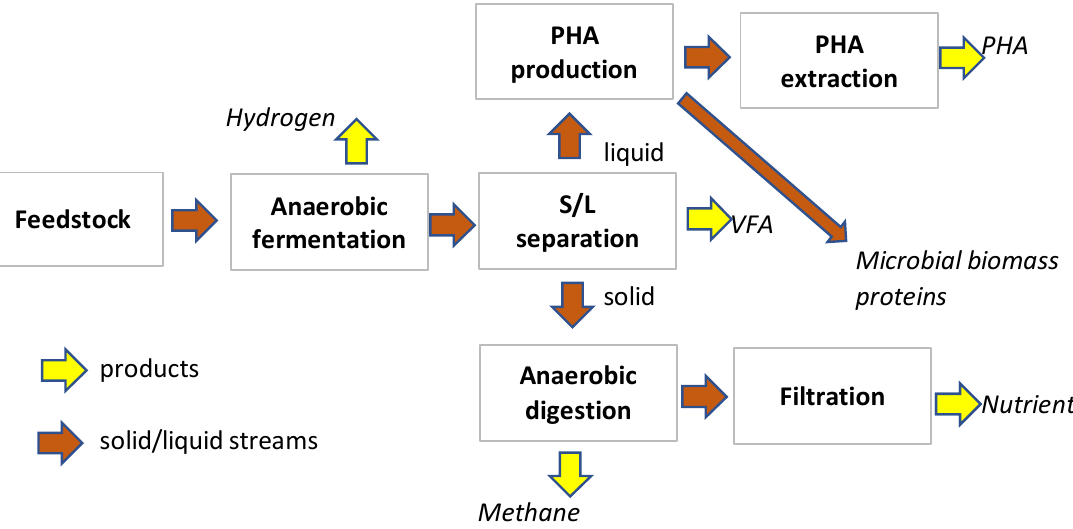
Figure 1. Scheme of the unit operations involved in the studied pilot scale process.